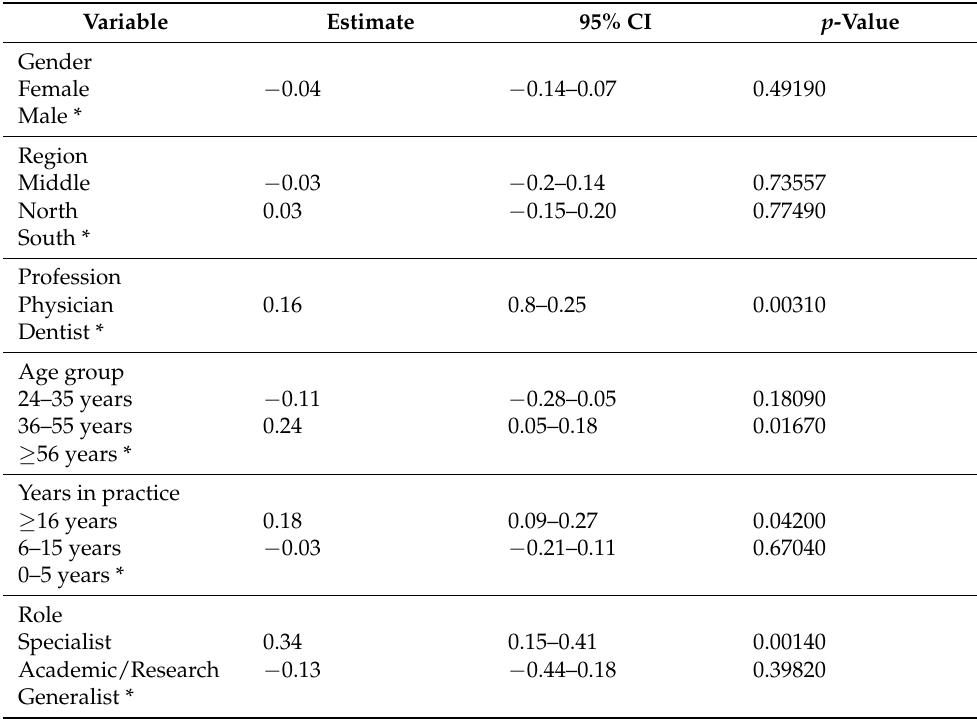
Table 4. Univariate analysis of the relationship between knowledge scores and demographic charac- teristics of